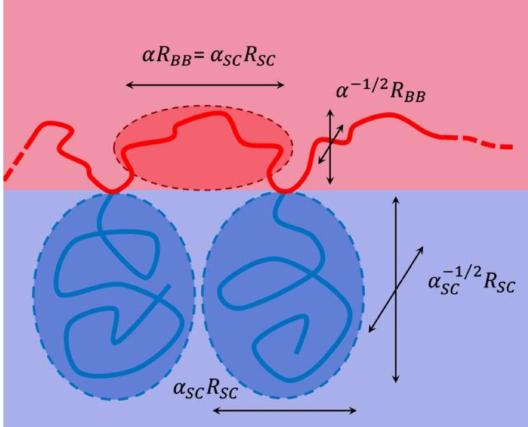
Figure 14. Sketch of the stretching model caused by the repelling side chains (blue) acting on the backbone (red). All of the polymers are in the microemulsion, either in the water (blue) or oil (red)